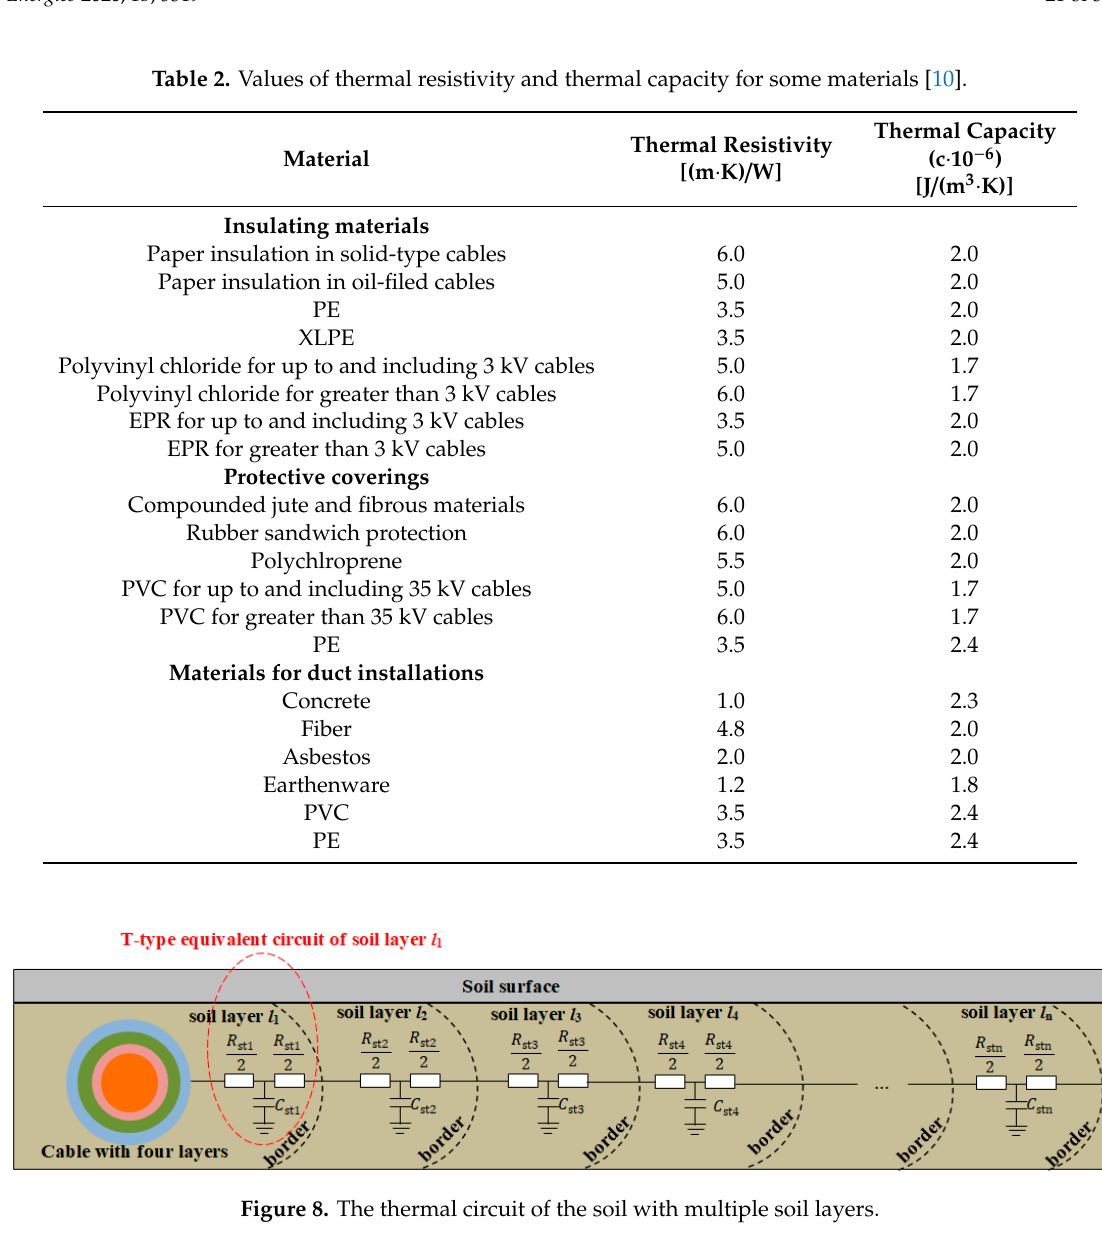
Figure 8. The thermal circuit of the soil with multiple soil layers.